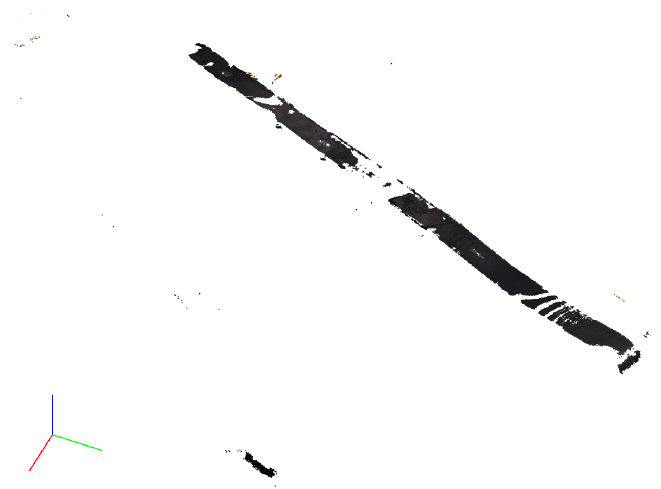
Figure 12. Belt detection enhanced with RANSAC plane